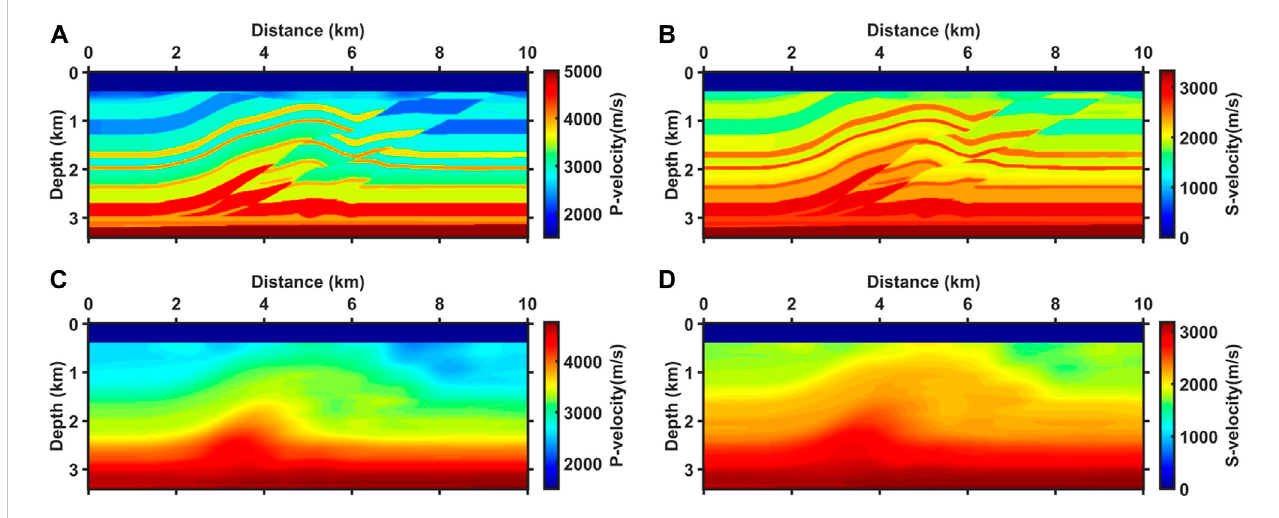
FIGURE 2 The true P-wave velocity (A) and S-wave velocity (B) models and their starting models (C,D)